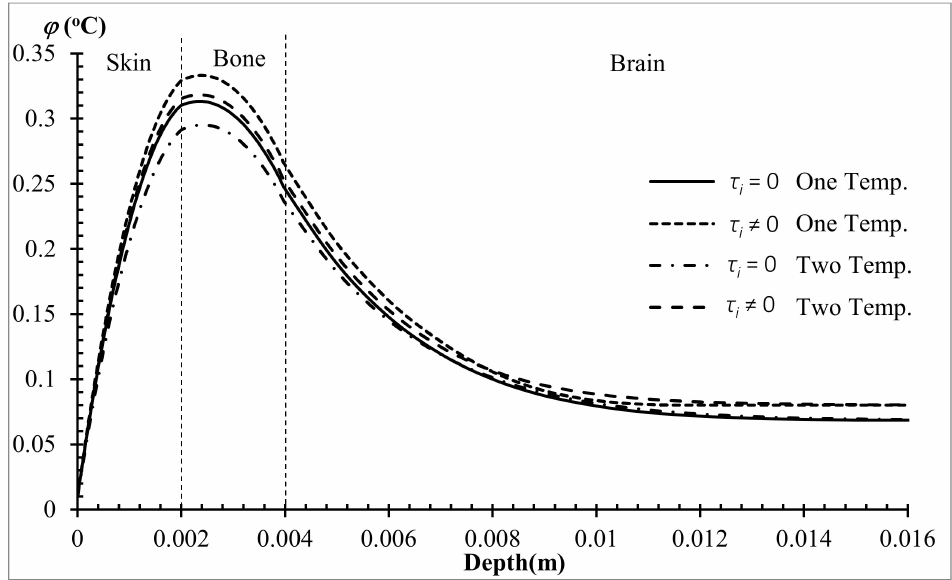
Figure 9. The conductive temperature increment with various relaxation times on a child’s